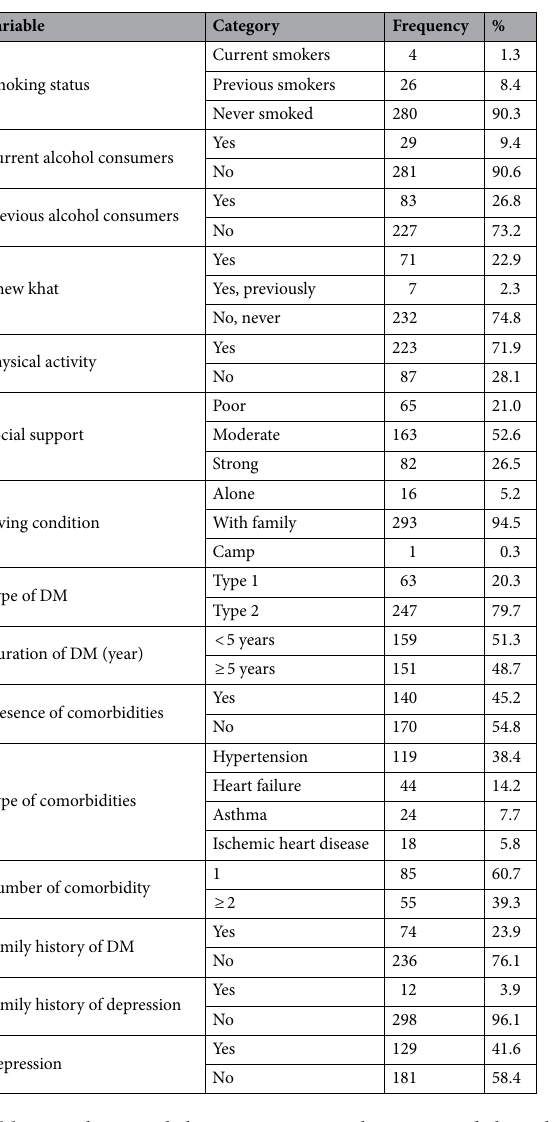
Table 2. Behavioural characteristics, social support and clinical characteristics of the study participants,